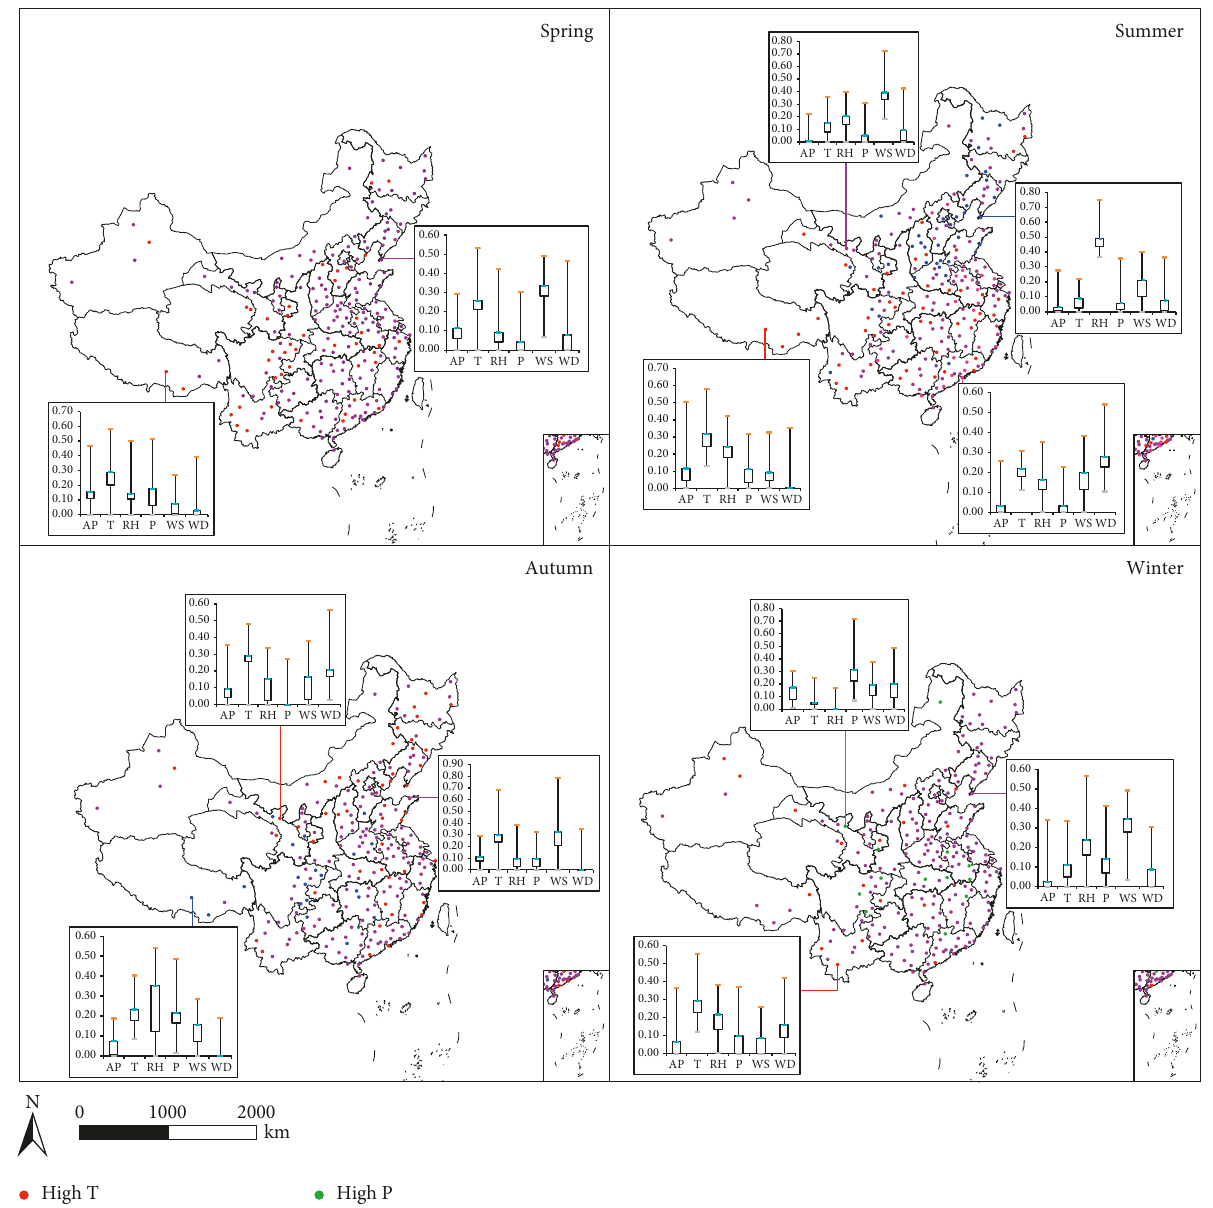
Figure 14: Relationship between NO 2 concentration and meteorological